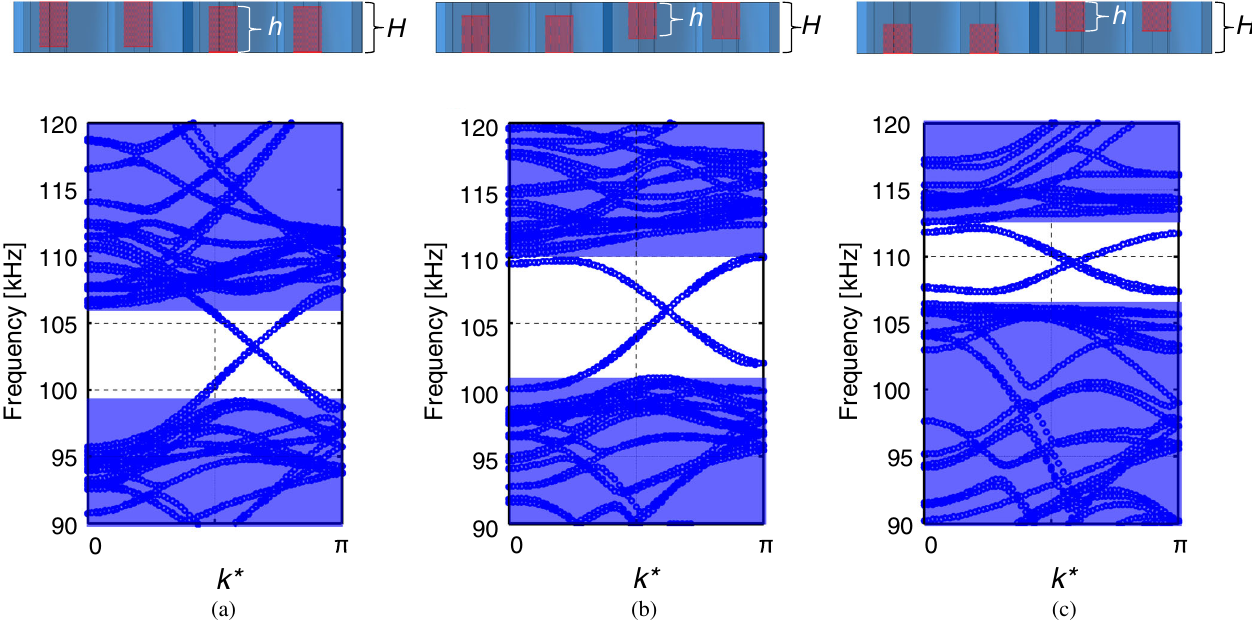
FIG. 3. Effect of the depth of the blind holes on the dispersion diagrams. (a) – (c) The dispersion diagrams for 10 × 1 strips periodic in the a 1 direction with a domain wall and blind hole depth of (a) h=H ¼ 0 . 98 ( H − h ¼ 0 . 1 mm), (b) h=H ¼ 0 . 92 ( H − h ¼ 0 . 5 mm), and (c) h=H ¼ 0 . 58 ( H − h ¼ 2 . 5 mm). Decreasing the height of the blind holes causes the relative width of the band gap to